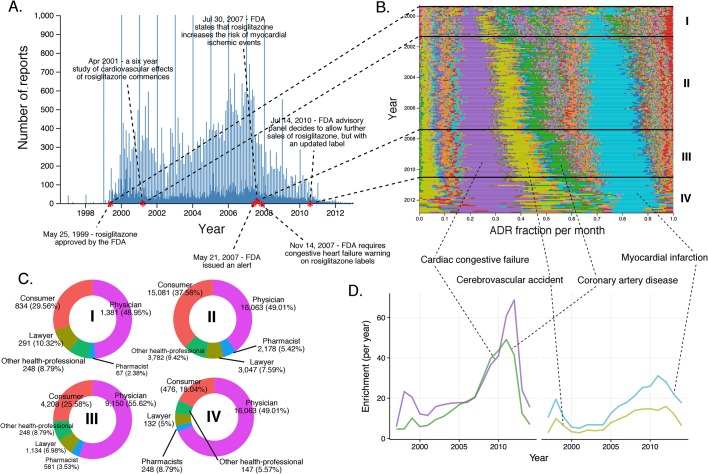
Rosiglitazone reports.(A) Number of FAERS reports (per day) where rosiglitazone was reported as primary suspect. (B) Per-month percent participation of all PT-level ADRs observed for rosiglitazone. Each ADR is represented by a separate color. Characteristic time periods on the timeline of this drug are demarked by lines, and numbered. Monthly ADR fractions shown here are also reported in Supplementary file 1. (C) Identities of those reporting rosiglitazone ADRs at various reporting periods, marked to correspond with the Roman numeral annotations in panel B. (D) Enrichment-based clusters of ADRs observed in rosiglitazone reports.